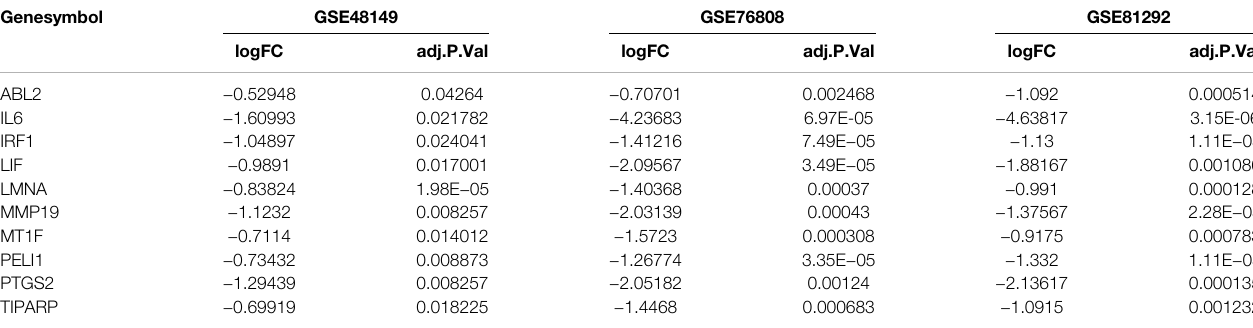
TABLE 1 | The common genes identi fi ed in the microarray dataset GSE48149, GSE76808, and GSE81292.